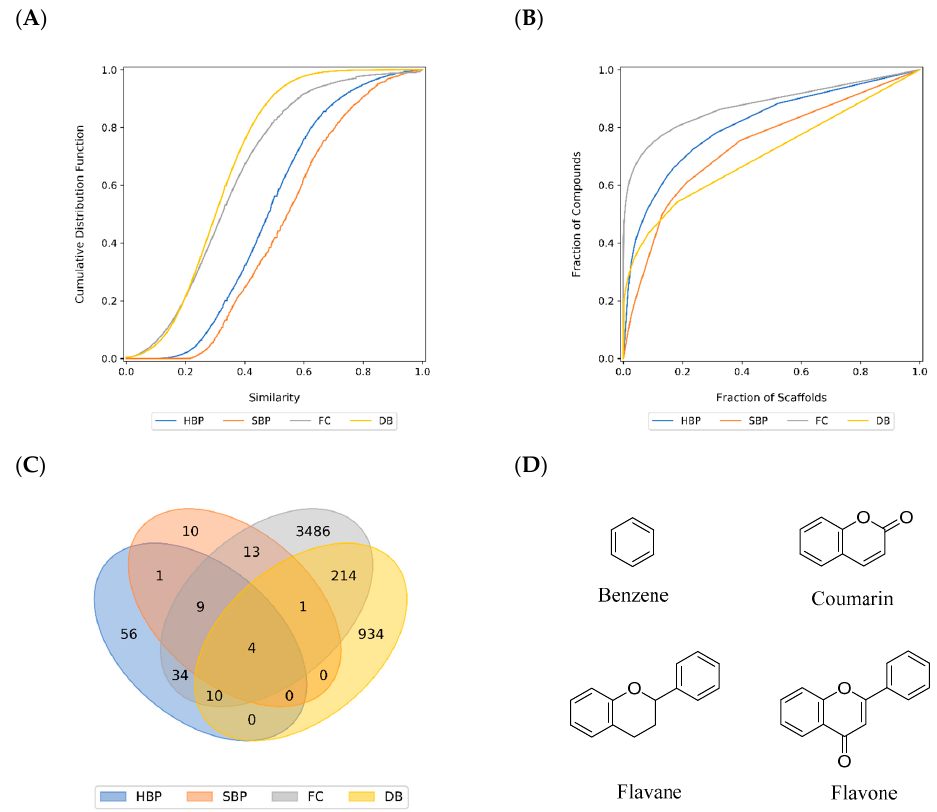
Figure 11. Structural diversity of HBP, SBP and reference compound datasets. ( A ) Fingerprint-based diversity; ( B ) sca ff old diversity—CSR curve; ( C ) sca ff old overlap; ( D ) four overlapped sca ff olds present in all four